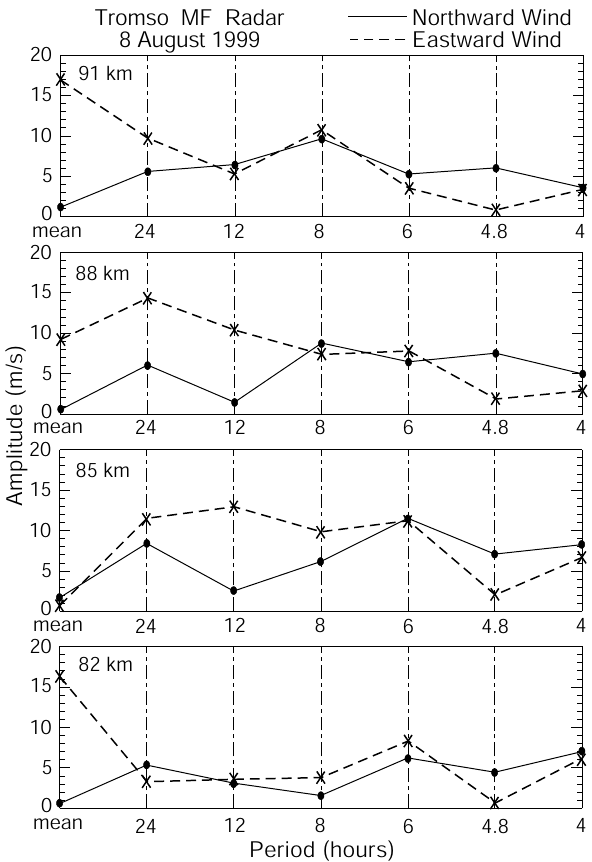
Fig. 5. Amplitude distributions of mean and tidal components of northward and eastward winds observed at four altitudes with the Tromsø MF